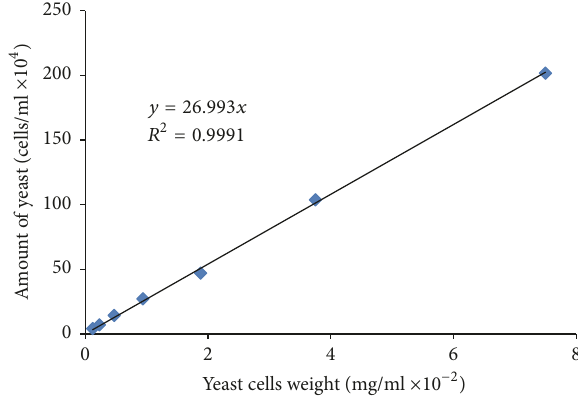
Figure 2: Calibration curve that correlates the number of yeast cells with their